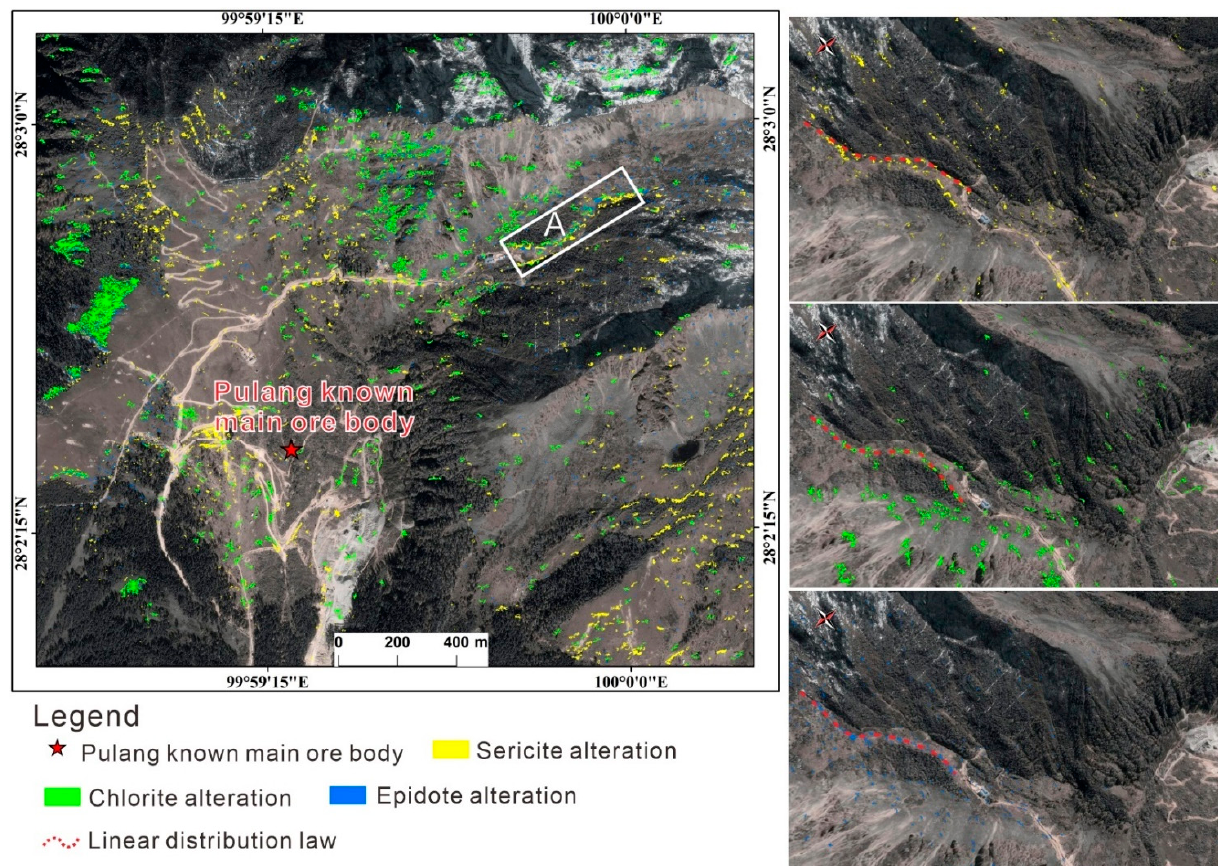
Figure 6. Distribution characteristics of alteration minerals extracted from area A and their linear patterns.